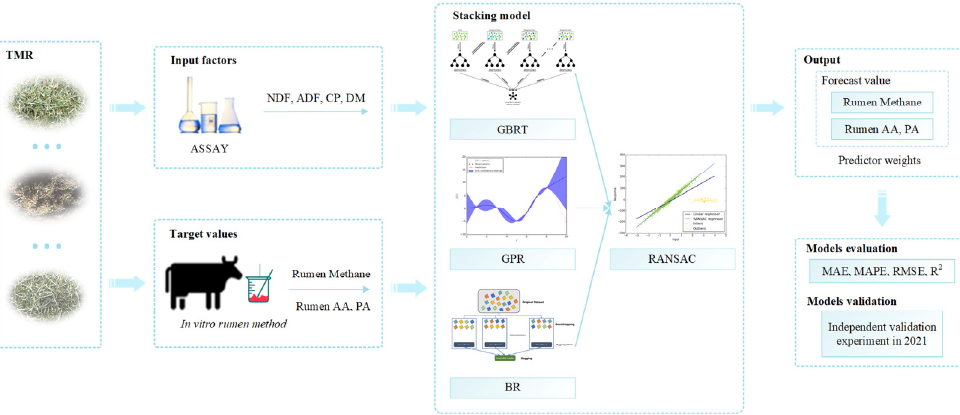
Figure 3. The workflow in this study was divided into four parts: inputting predictor variables and target variables; modeling through the stacking ensemble learning method; outputting results; and evaluating and validating.